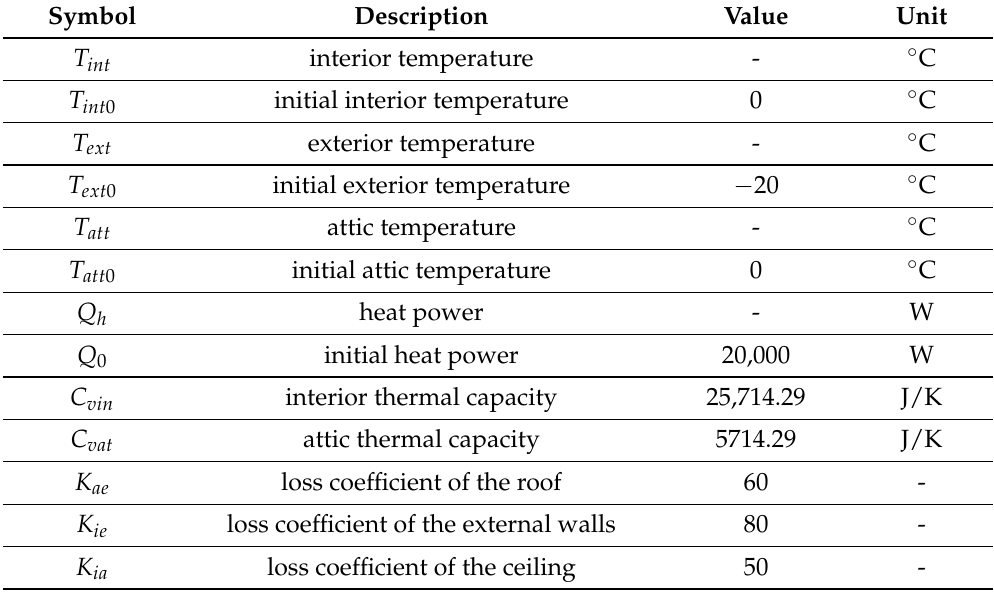
Table A2. The two-level thermal object